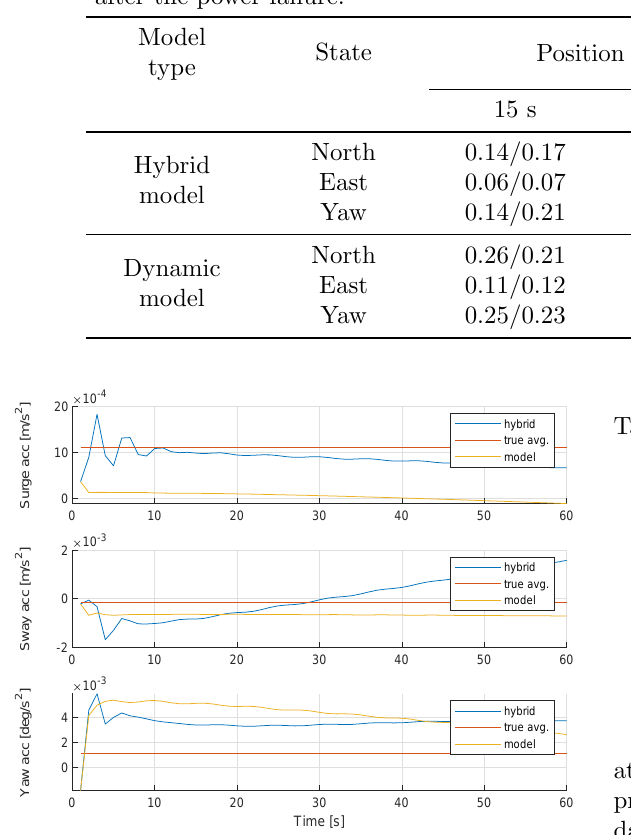
Figure 5: The accelerations related to the first predic- tion interval starting from the point of fail- ure. Note that the actual acceleration (red line) is given as the average of the 60 second prediction interval.